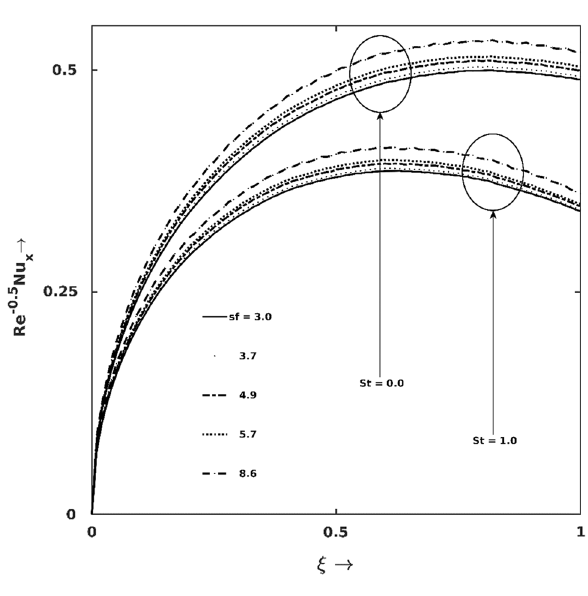
) graph for different St and φ . x